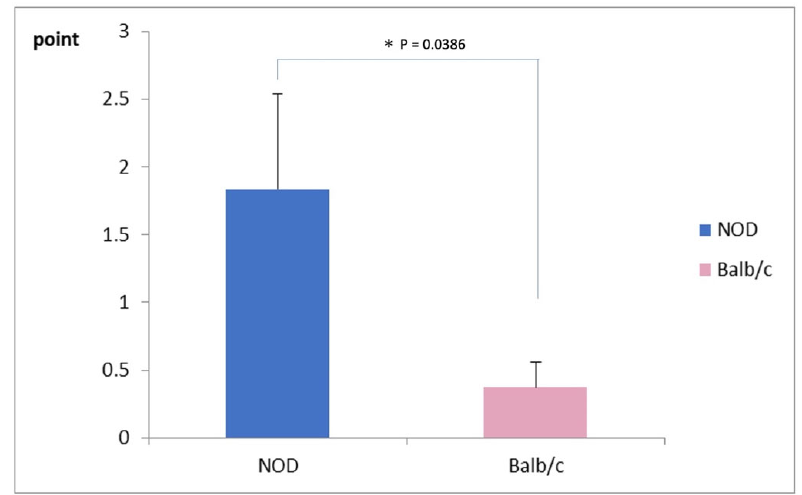
Figure 3. Comparison of corneal vital staining scores between NOD and the Balb/c mice. Note the significantly higher staining scores in the NOD mice compared to the WT mouse ( p = 0.03). * represents p < 0.05.